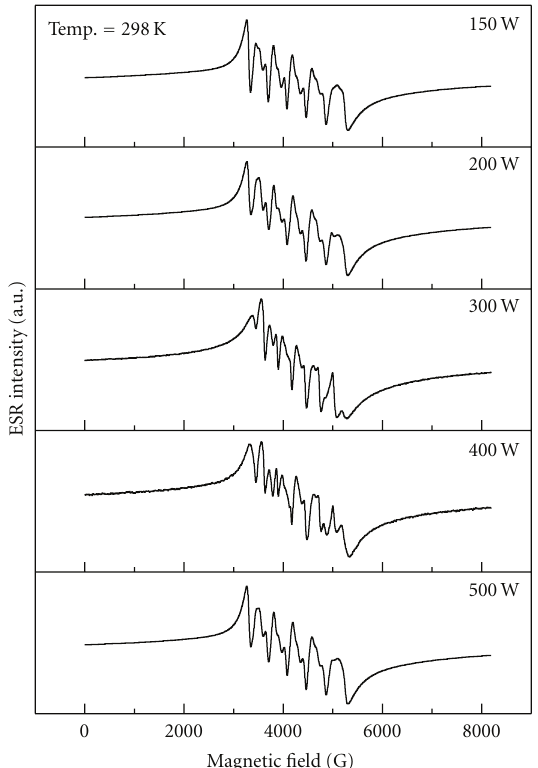
Figure 4: EPR spectra of 2-ethylhexanoic acid-coated ZnS:Mn 2+ nanoparticles prepared using di ff erent microwave